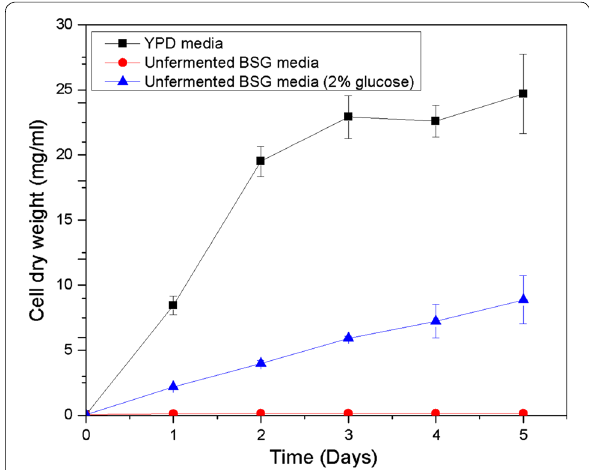
Fig. 1 Growth curves for R. toruloides when grown in YPD, unfer- mented BSG and unfermented BSG ( 2% w/w glucose) media repre- sented as cell dry weight (mg/ml) vs. time (days)